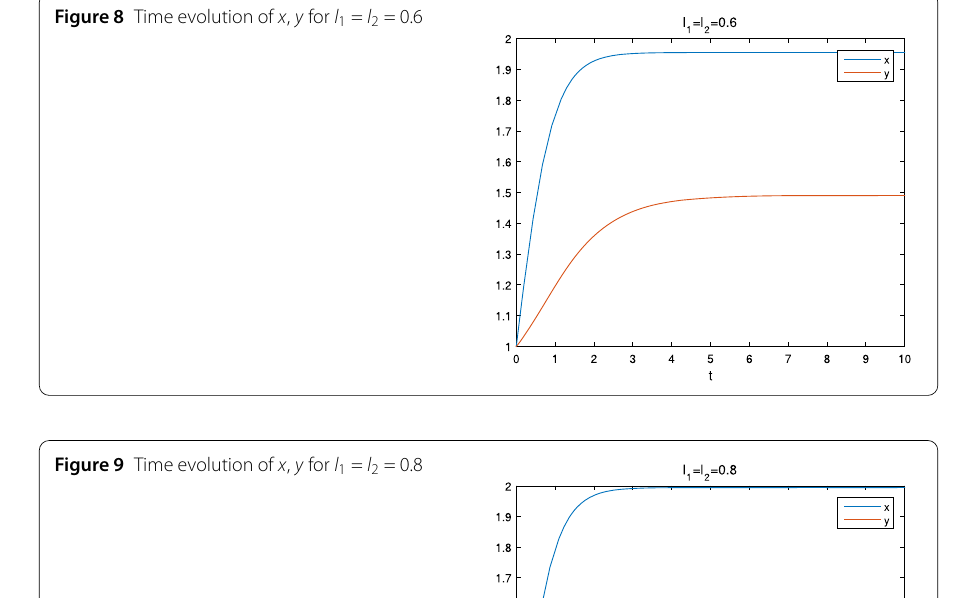
Figure 9 Time evolution of x , y for l 1 = l 2 = 0.8